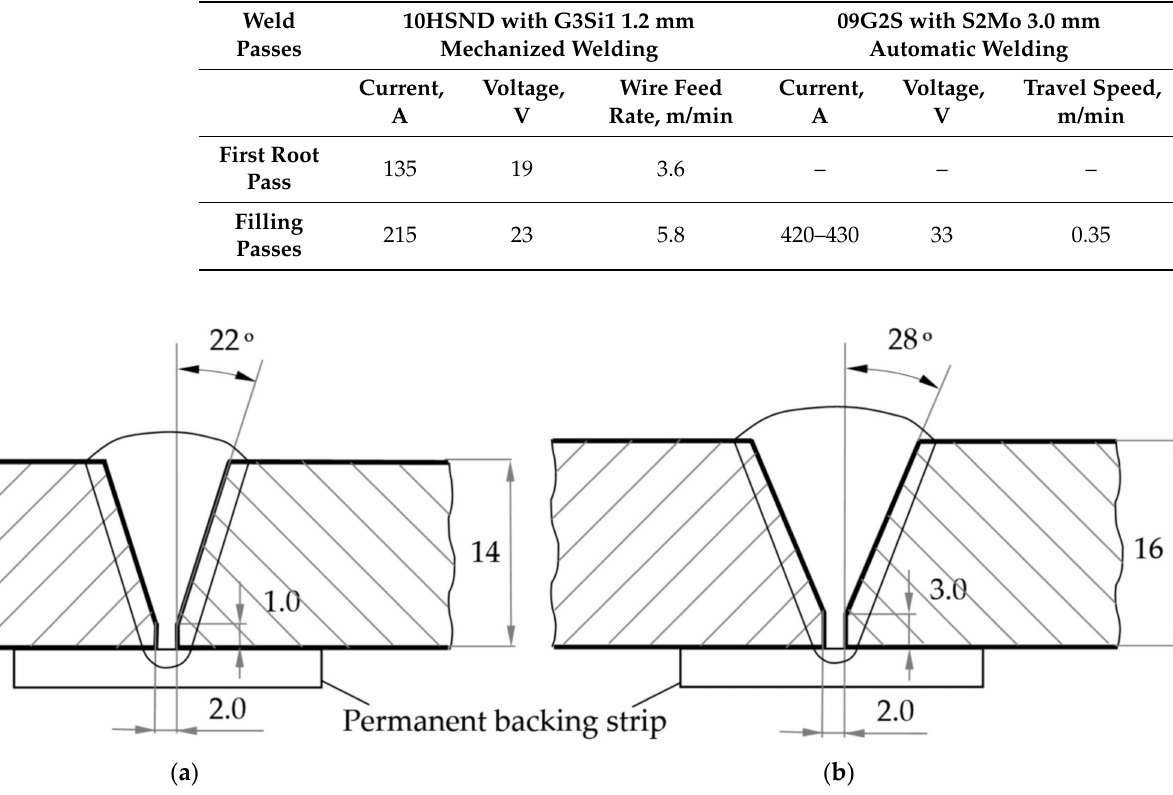
Figure 2. The design of butt joints: ( a ) in metal active gas (MAG) welding according to GOST 14771-76 in Russian; ( b ) in submerged arc welding (SAW) process according to GOST 8713-79 in Russian.